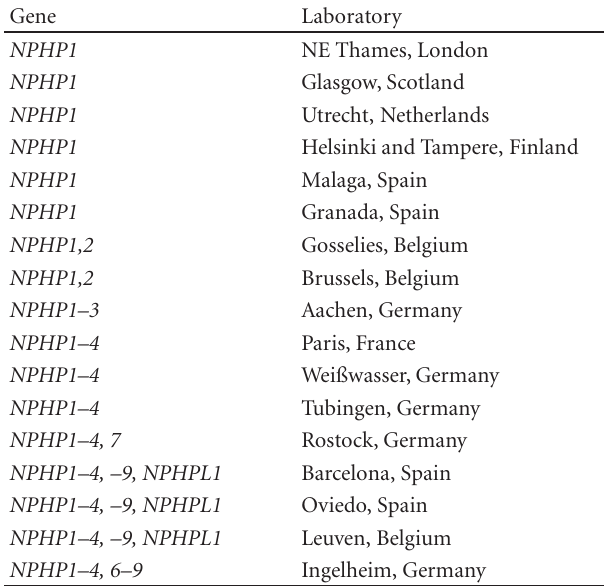
Table 2: NPHP genes available for testing via UK and European gene testing